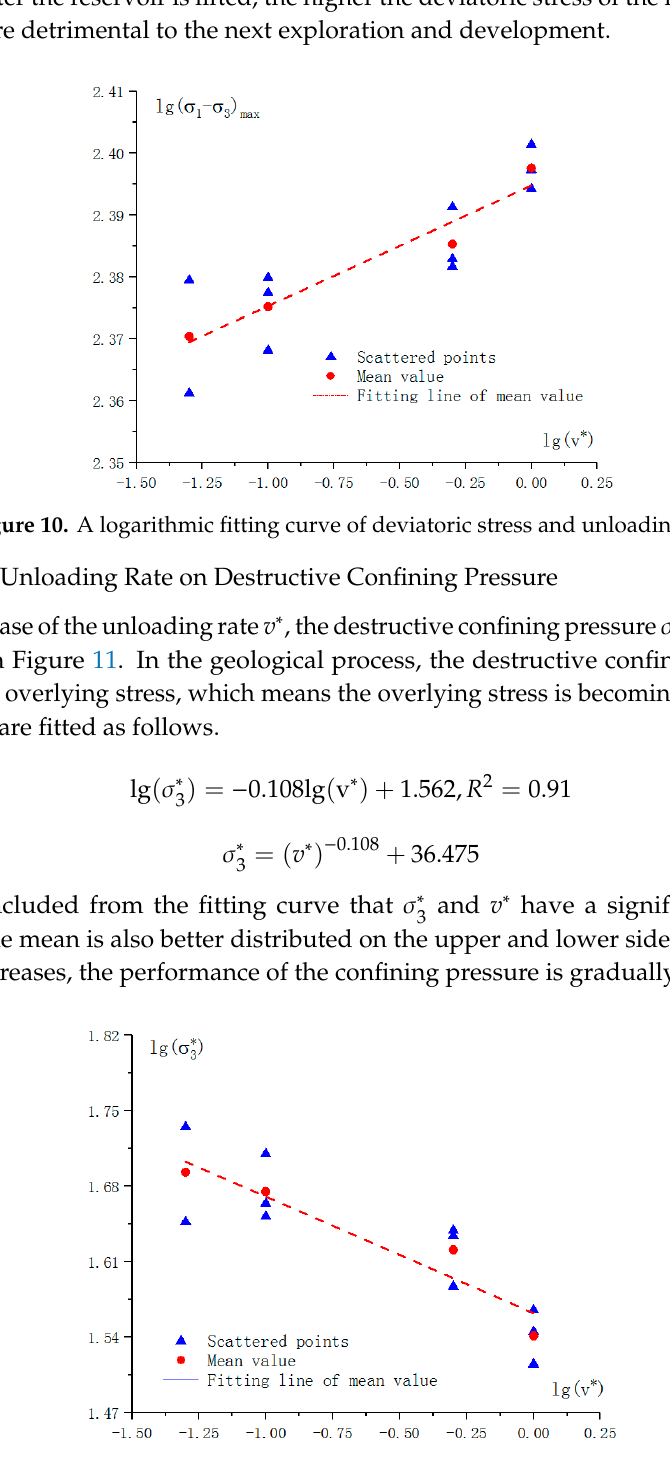
Figure 11. A logarithmic fitting curve of confining pressure and unloading rate.